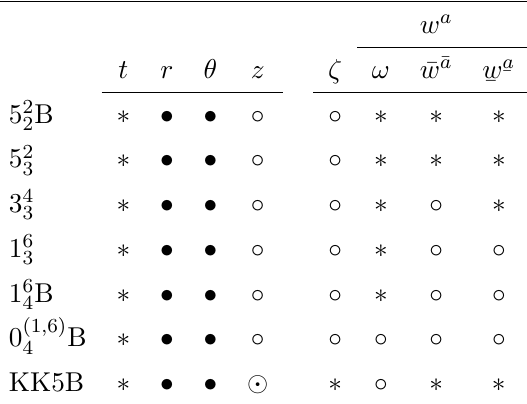
Table 3 . The con(cid:12)guration of the Type IIB branes that we